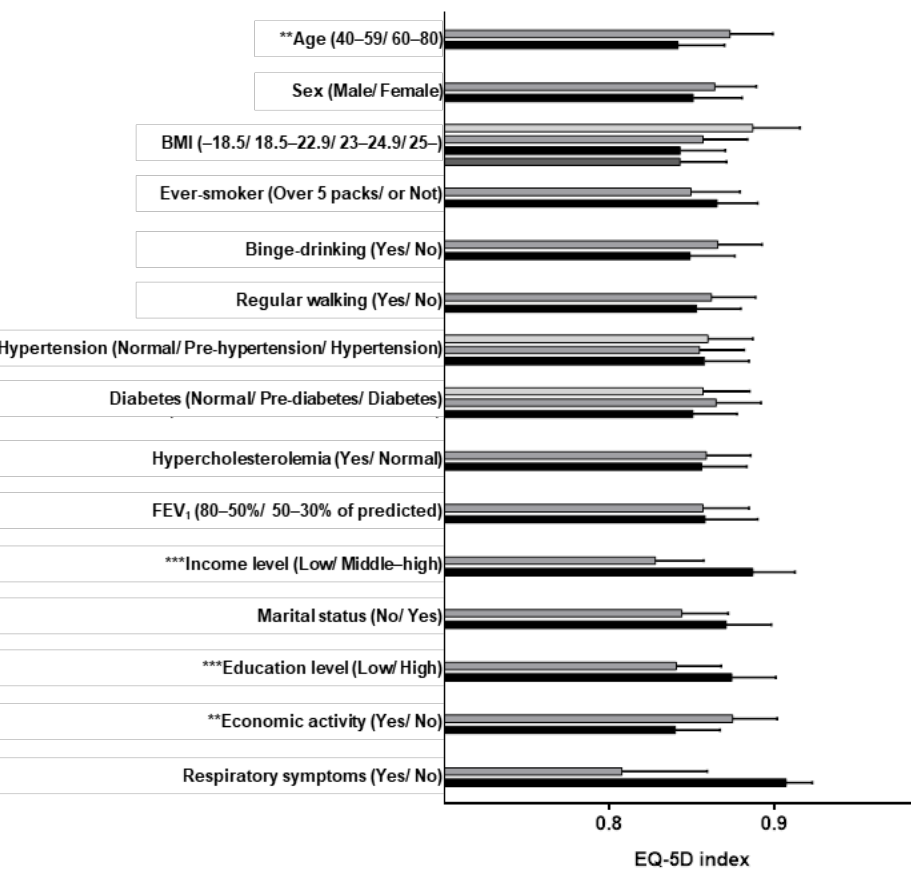
Figure 2. Factors influencing overall health-related quality of life in patients with preserved ratio impaired spirometry. Abbre- viations: BMI, body mass index; FEV 1 , forced expiratory volume in 1 s. Note: ** p < 0.01, *** p < 0.001.